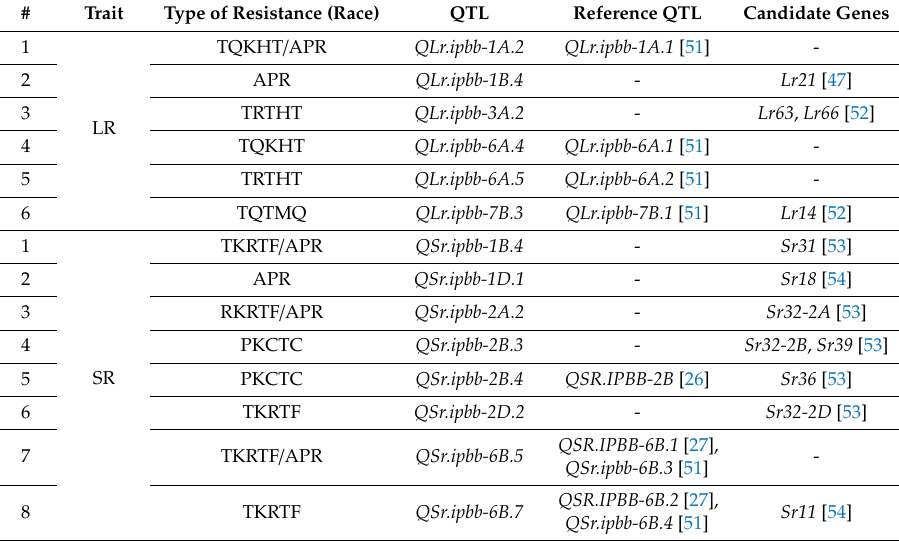
Table 9. Comparison of quantitative trait loci (QTLs) for leaf rust (LR) and stem rust (SR) resistance identified in this study in a Pamyati Azieva × Paragon mapping population with previously described QTLs and candidate Lr and Sr